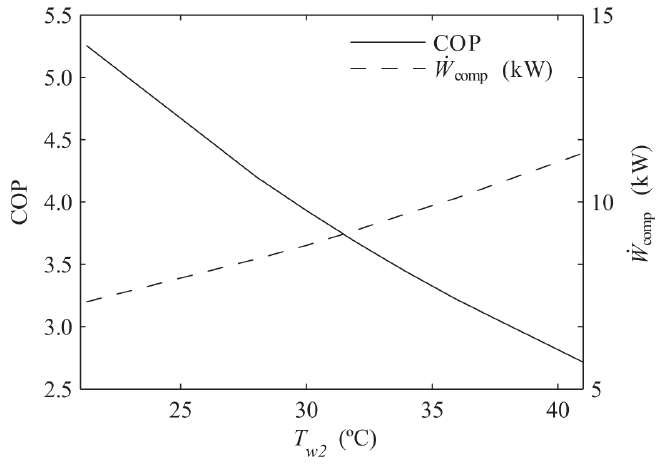
Figure 8. Coefficient of performance (COP) versus condenser water inlet temperature (range of 5 ◦ C). Airwell CWP 09